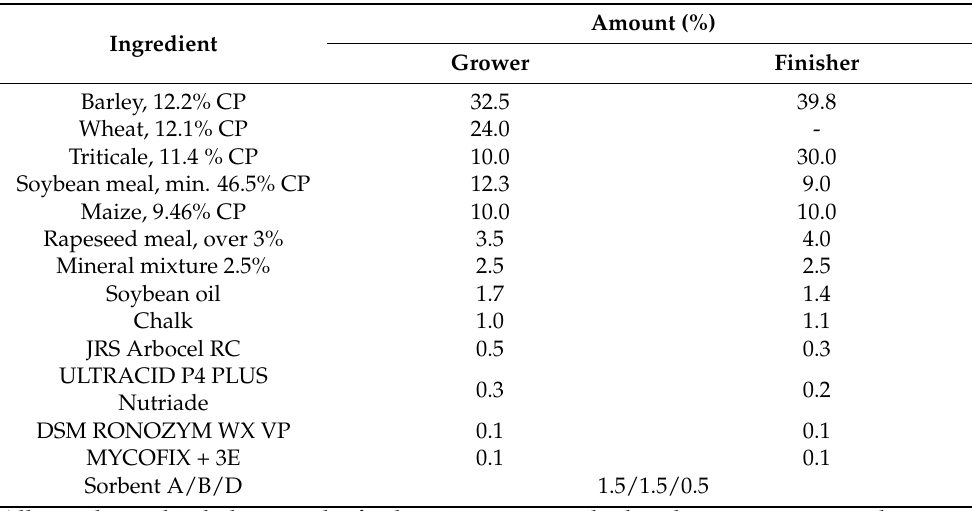
Table 1. Ingredients and chemical composition (%) of feed for pigs.